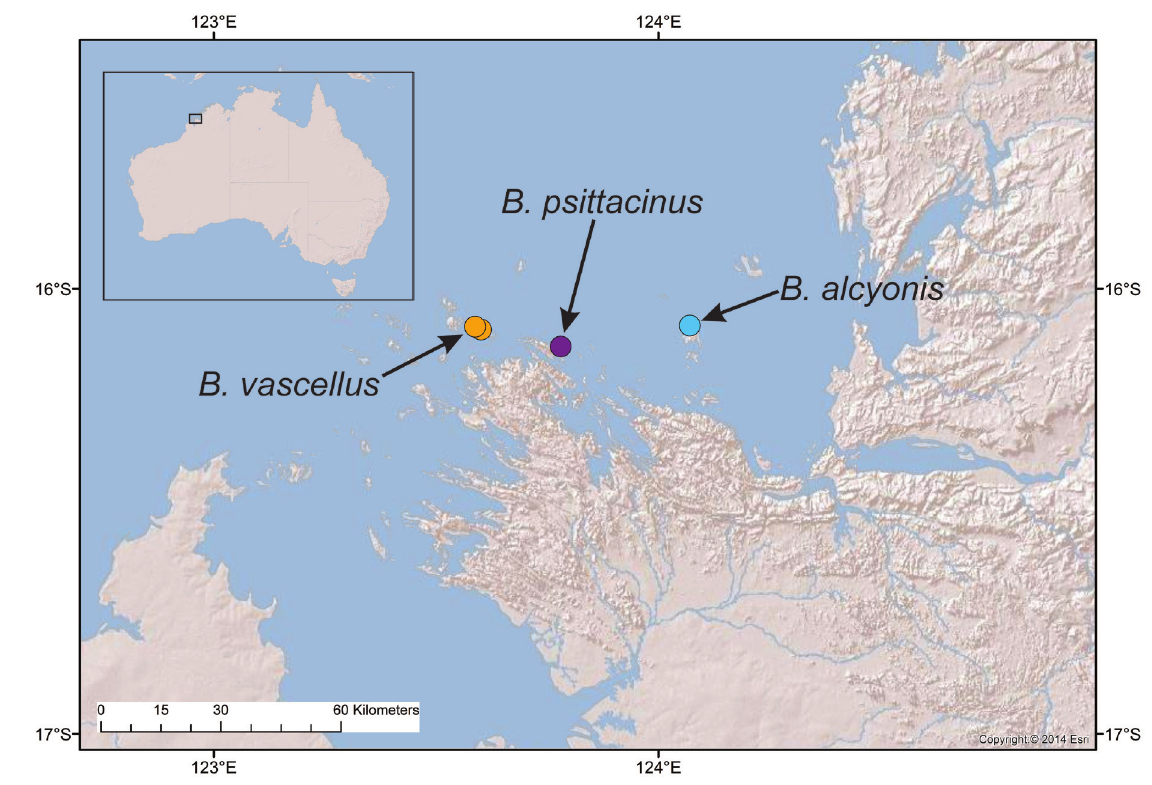
Fig. 5. Map of the Kimberley region of north-western Australia showing the distributions of the three new species of Boreohesperus